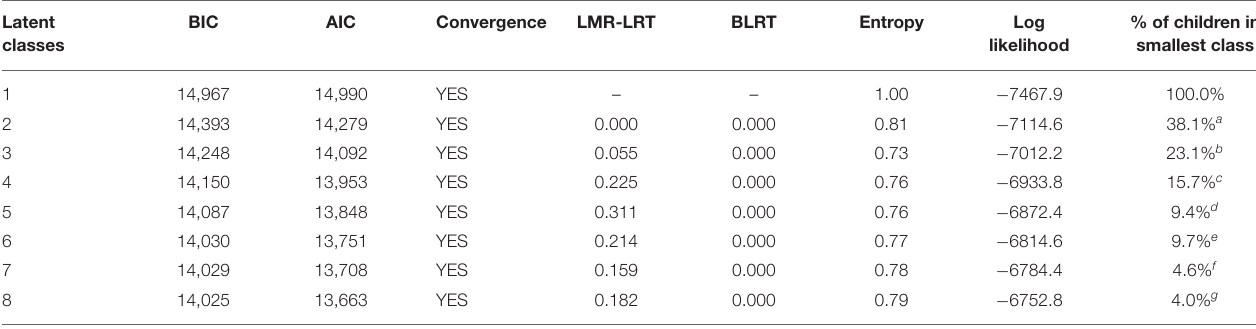
TABLE 2 | Model fit statistics.